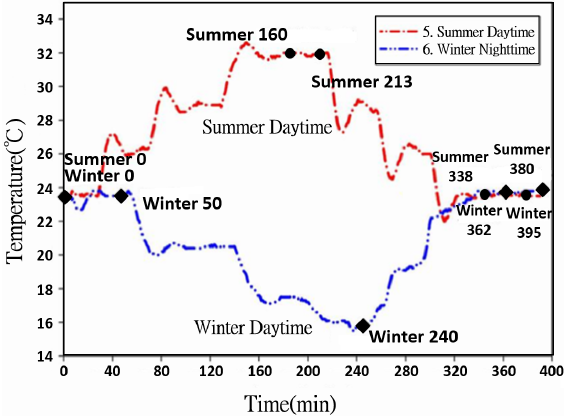
Figure 6. Temperature distributions within the environmental chamber according to time under summer daytime and winter nighttime operational conditions.